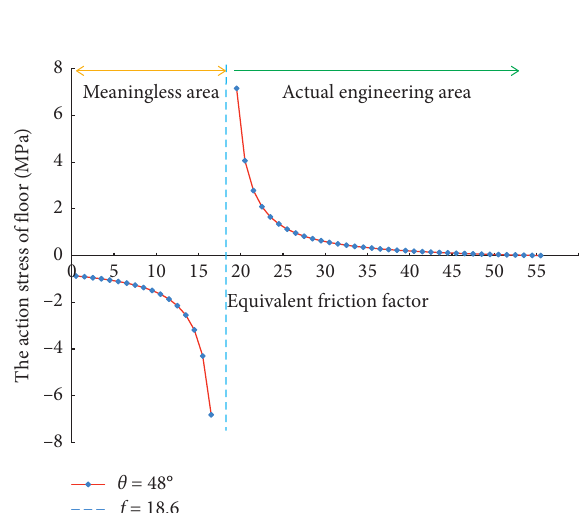
Figure 5: Relationship between floor action stress and equivalent friction